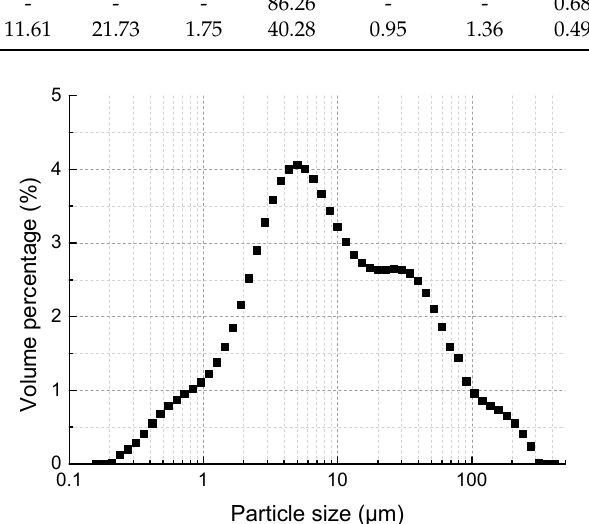
Figure 3. Particle size distribution of compound calcium-based stabilizer.